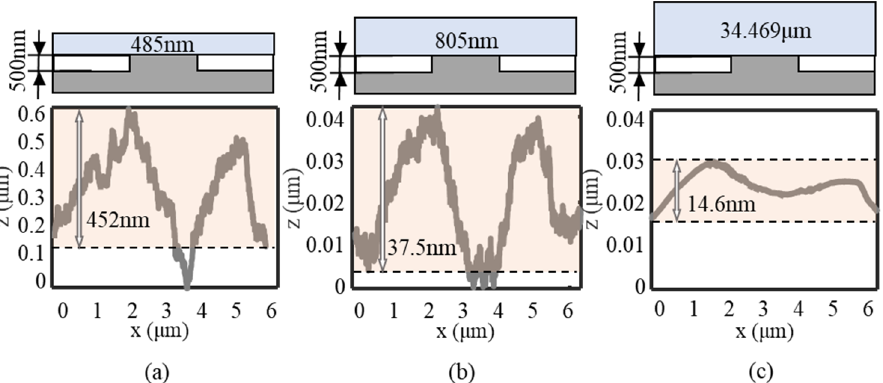
Figure 8. The measurement results of subsurface microstructures using the CR-AFM. ( a – c ) show the subsurface line scan results of the samples with 485 nm, 805 nm, and 34.469 µ m HOPG film thicknesses, respectively.